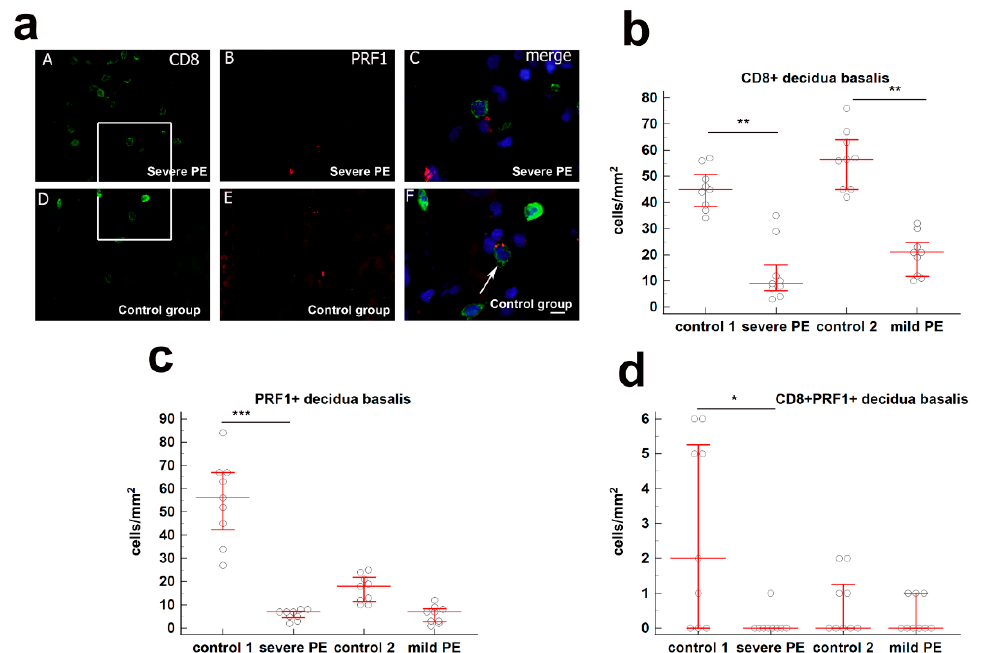
Figure 1. ( a ) ( A – C ) Co-expression of CD8 and PRF1 markers in decdua basalis cells of the third trimester pregnancies in severe PE. Double immunofluorescence staining showed CD8 ( A ) and PRF1 ( B ) positive cells. Merging ( A ) and ( B ) revealed no co-expression of CD8 and PRF1 ( C ). Scale bar = 10 µ m. ( D – F ) Co-expression of CD8 and PRF1 markers in decdua basalis cells of the third trimester pregnancies in control group. Double immunofluorescence staining showed CD8 ( D ) and PRF1 € positive cells. Merging ( D ) and ( E ) revealed co-expression of CD8 and PRF1 (arrow) ( F ). Scale bar = 10 µ m. Magnification frame on ( A ) and ( D ) is shown on ( C ) and ( F ), respectively; magnification on ( A , B , D , E ) is × 40; magnification on ( C ) and ( F ) is × 80. Expression of ( b ) CD8 + , ( c ) PRF1 + , and ( d ) CD8 + PRF1 + in decidua basalis in severe PE ( n = 9), mild PE ( n = 9) and healthy age-matched control 1 ( n = 9) and control 2 ( n = 9). Data are presented as the median ± interquartile range (vertical line). Significant differences were indicated by p * < 0.01, p ** < 0.001, p *** < 0.0001 (Kruskal–Wallis test followed by Dunn’s multiple comparison test).